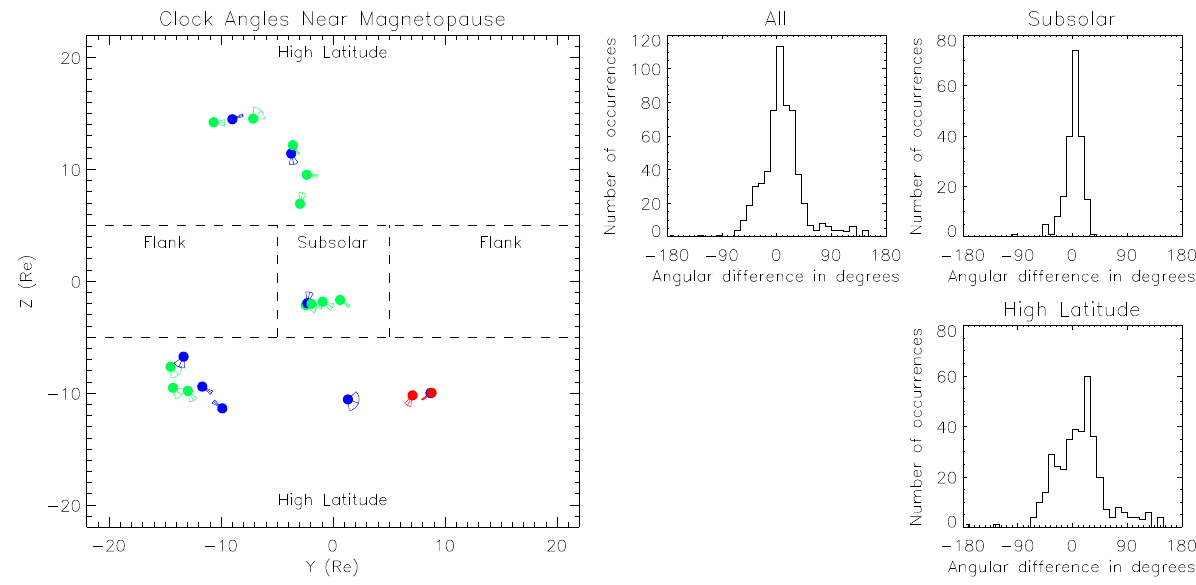
Fig. 10. Clock angles measured near magnetopause, and angular differences from perfect draping, for low solar wind dynamic pressure. Format as Fig.